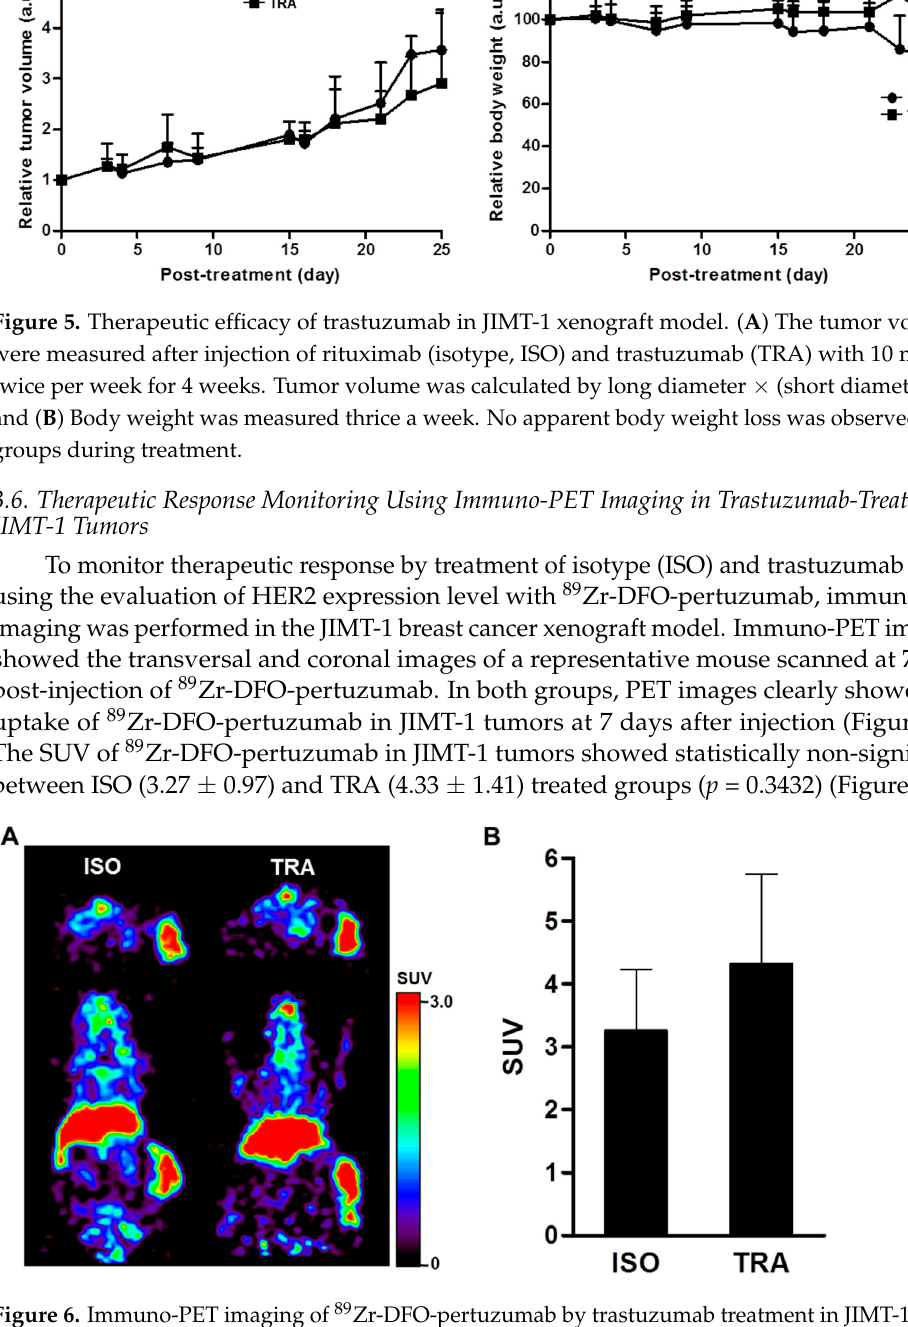
10 of 20 Figure 4. Immuno-PET imaging of 89 Zr-DFO-pertuzumab in HER2-positive (JIMT-1) and -negative (MDA-MB-231) breast cancer xenograft models. PET images were acquired at 1 day, 5 days, and 7 days after injection of 89 Zr-DFO-pertuzumab in ( A ) HER2-positive (JIMT-1) and ( B ) -negative (MDA-MB-231) tumors. Tumors are indicated as yellow dotted circles. The tumor uptake of 89 Zr-DFO-pertuzumab was similar to that of the liver on day 1, but JIMT-1 tumor uptake increased, and liver uptake decreased in a time-dependent manner. At the same time, the uptake in the MDA-MB-231 tumor was relatively lower than that in the liver as time elapsed. All images were represented as the percentage of the injected radioactivity dose per gram of tissue (%ID/g). 3.5. Therapeutic Effects of Trastuzumab in the JIMT-1 Xenograft Model Anti-tumor effects of trastuzumab were assessed in the JIMT-1 xenograft model